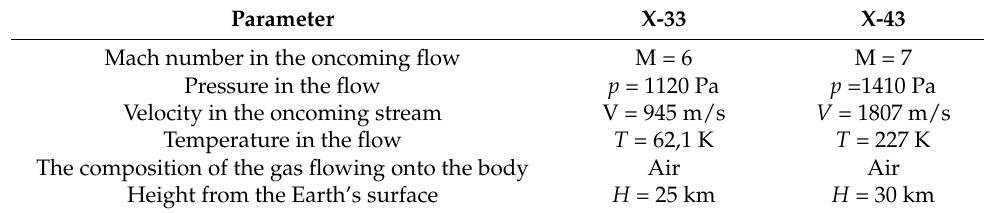
Table 1. Main parameters of the oncoming flow.